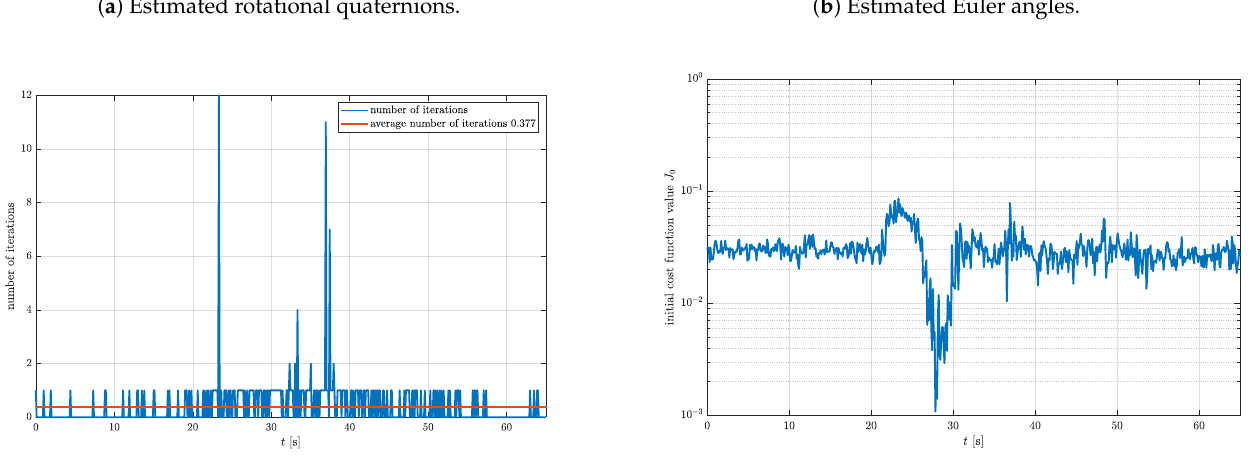
Figure 10. Experimental results obtained with parameters µ = 0.7, q 0 = G max = 3 × 10 − 2 , and K = 0.5.